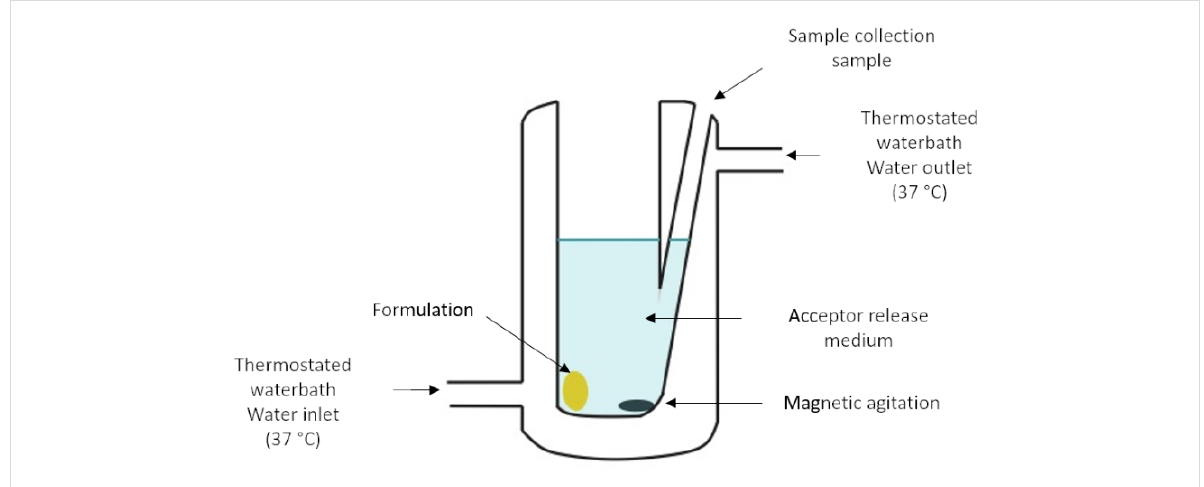
Figure 15: Schematic presentation of the modified Franz’s cell used for the in vitro curcumin release measurements from the nanostructured system.